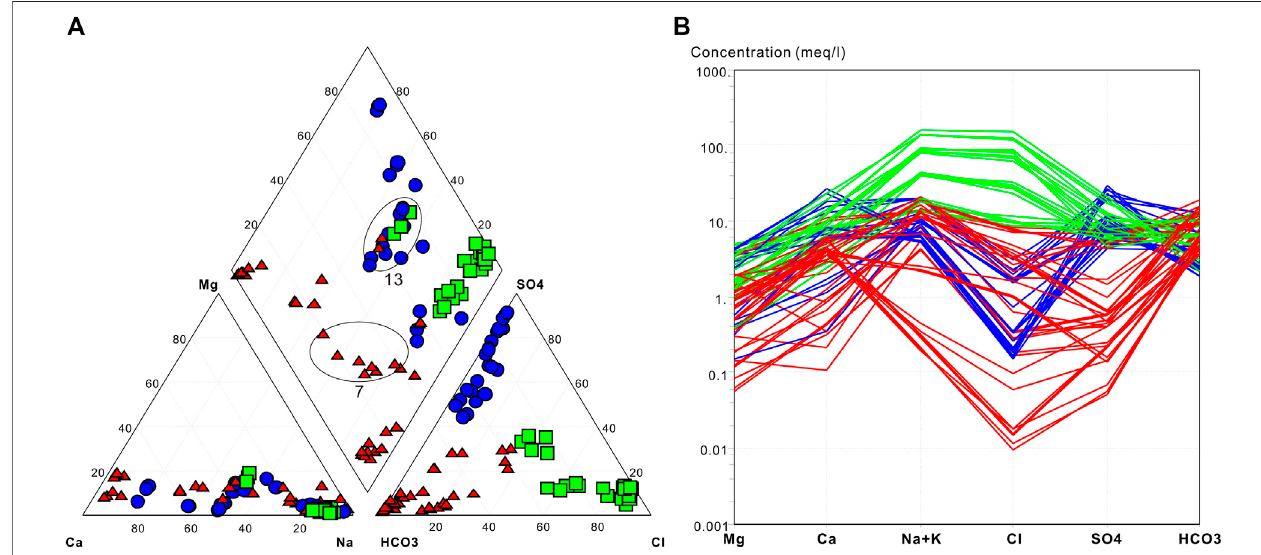
FIGURE 2 | Piper diagram (A) and Schoeller diagram (B) of the geothermal waters. Process (black circles) indicating the changes before and after the Mojiang earthquake.